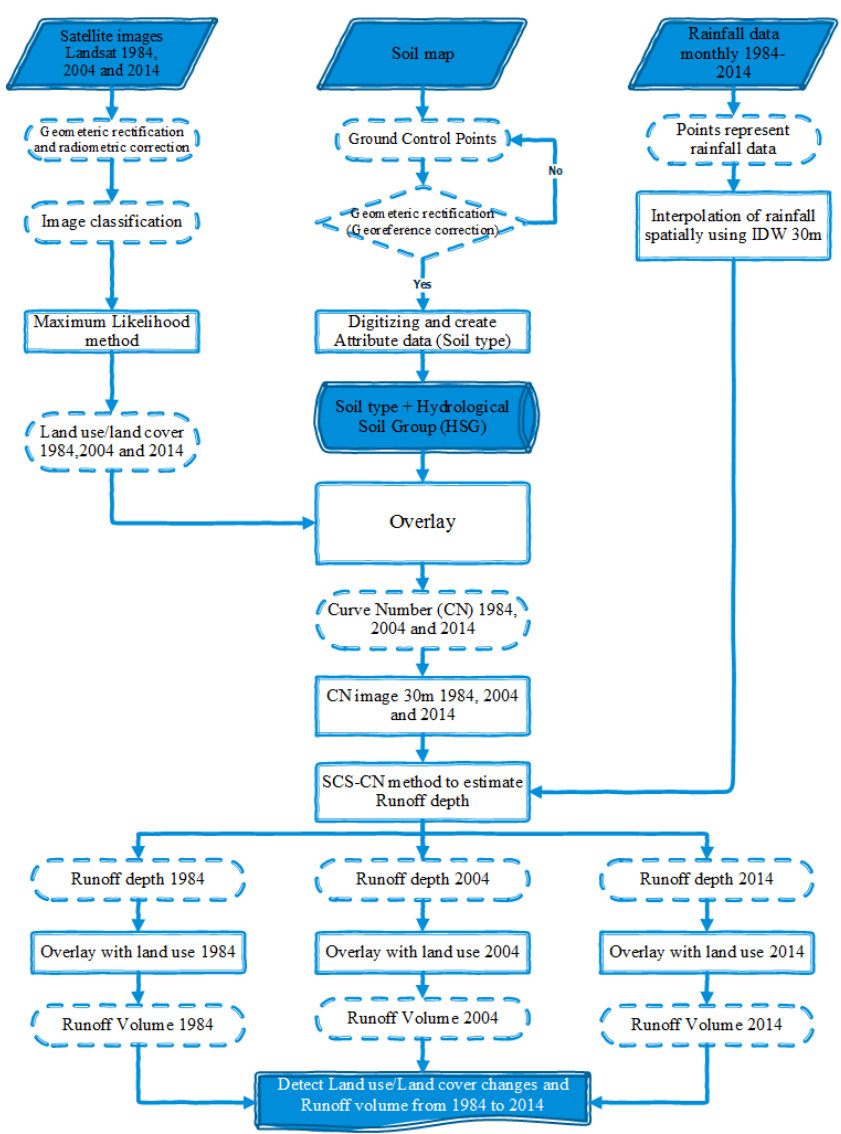
Figure 6. Flowchart of the methodology used to estimate the spatial and temporal variations of runoff depth.